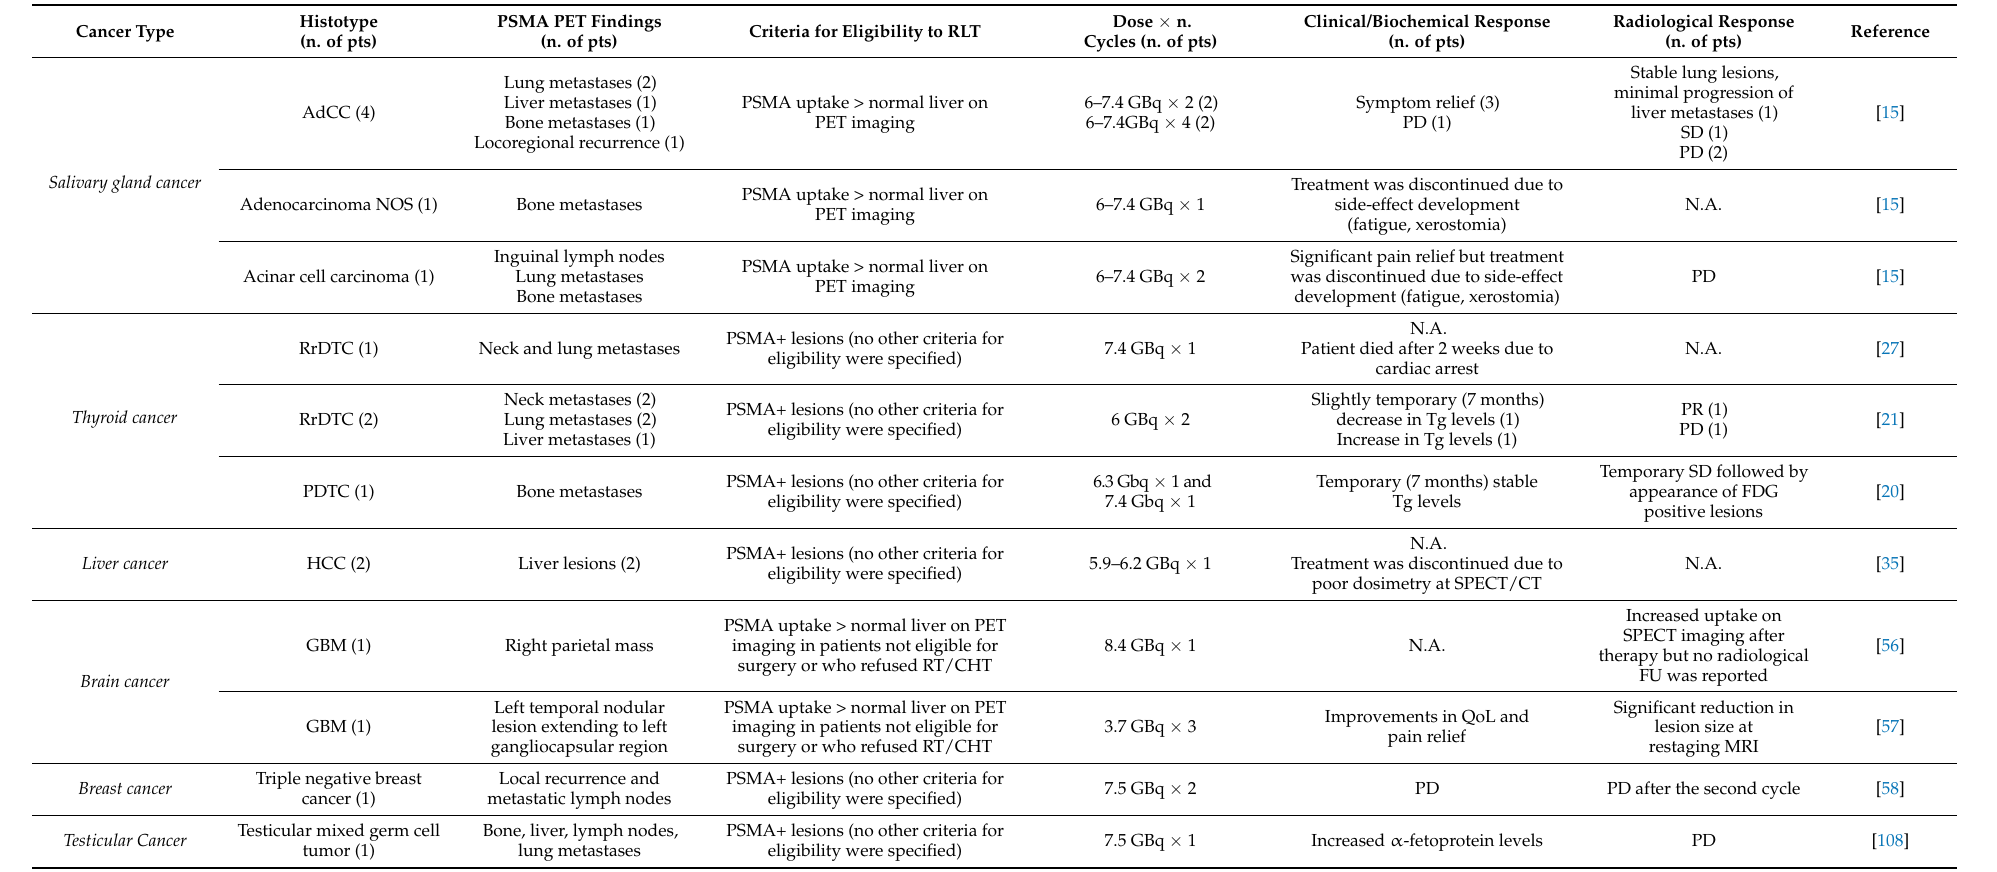
Table 1. Patients with non-prostate cancer treated with PSMA